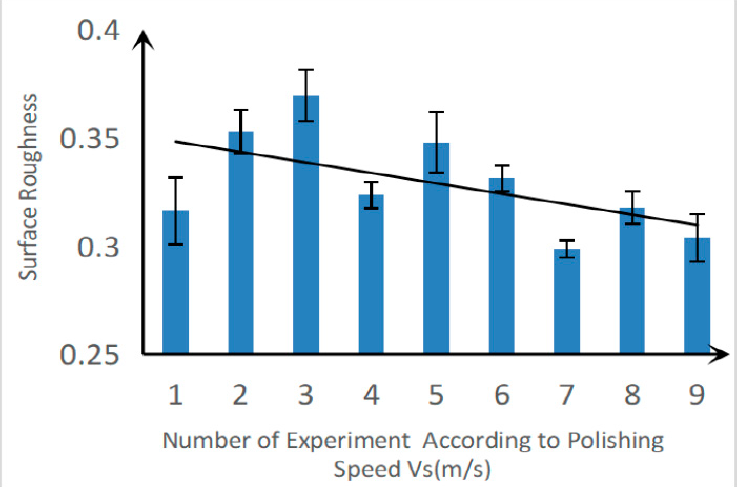
Figure 9. Relationship between the surface roughness and the belt line speed.